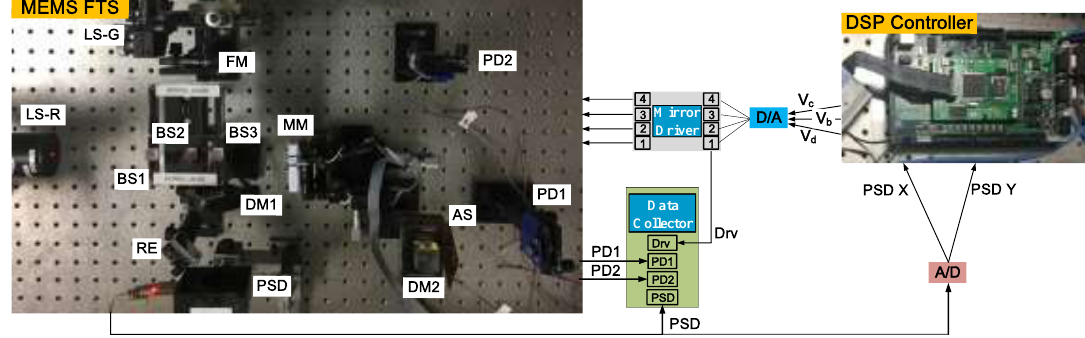
Figure 16. Experimental setup for MEMS FTS control system.